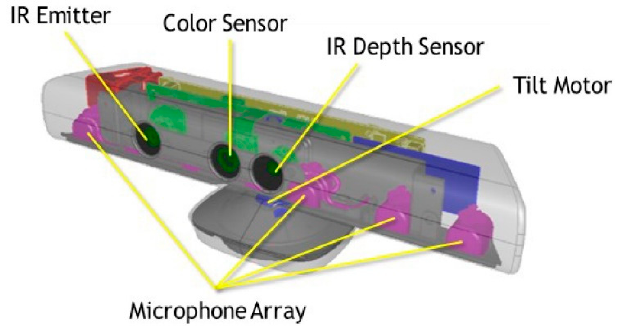
Figure 1. Xbox Kinect with selected sensors. IR Emitter, Color Sensor, IR Depth Sensor (element of structural light sensor), Tilt Motor, Microphone Array. The image does not include the accelerometer [24].